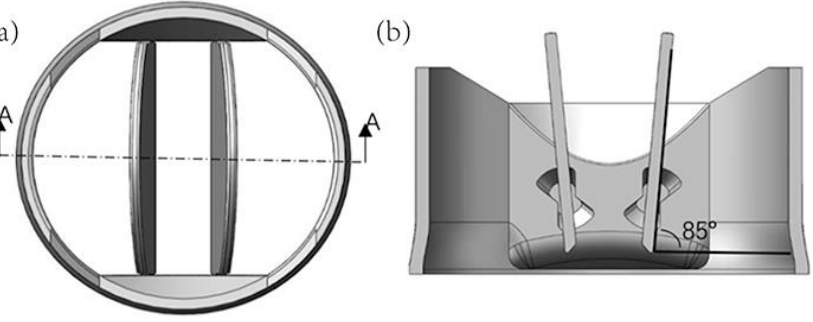
Figure 4. The leaflet angle at the fully open position ( a ) Top viw of MHV, ( b ) Cutaway view of MHV.